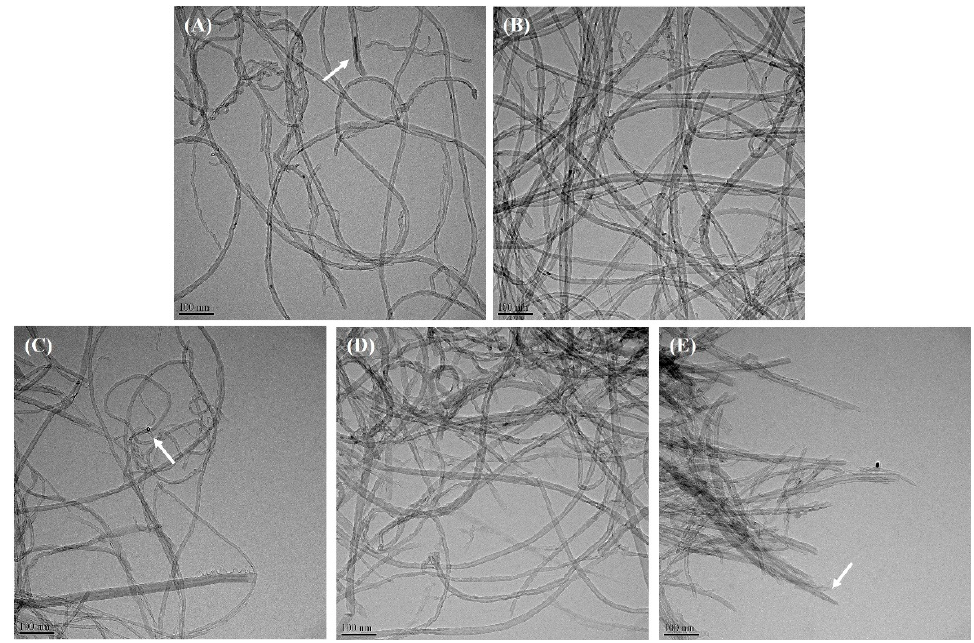
Figure 2. TEM images of the ( A ) raw MWCNTs (RCNTs), ( B ) alkalized MWCNTs (ACNTs), ( C ) oxidized MWCNTs (OCNTs), ( D ) double-oxidized MWCNTs (DOCNTs), and ( E ) ground MWCNTs (GCNTs).